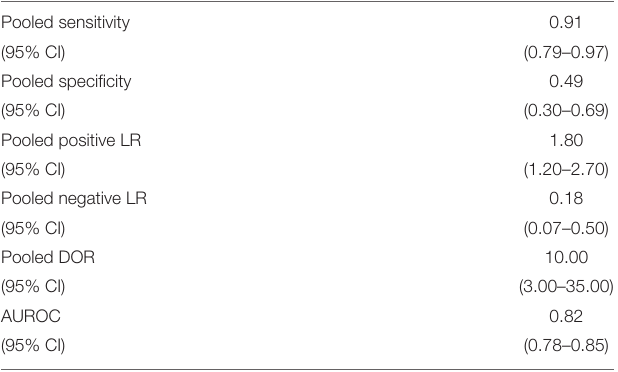
TABLE 3 | Pooled sensitivity, pooled specificity, pooled likelihood rations, and AUROC of micro-ultrasound.